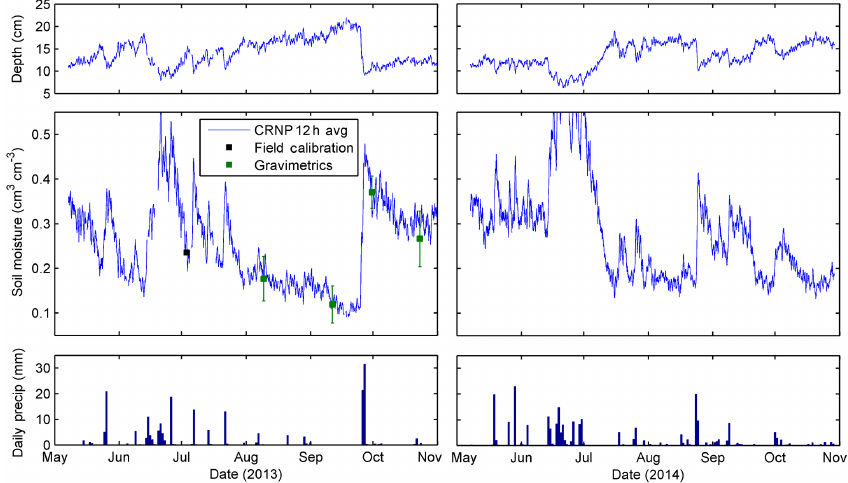
Figure 2. Field average soil moisture measured by cosmic-ray neutron probe (12h running average), as compared to gravimetric soil samples (average ± 1SD) and precipitation for 2013 and 2014. The changing measurement depth is shown in the top graph.